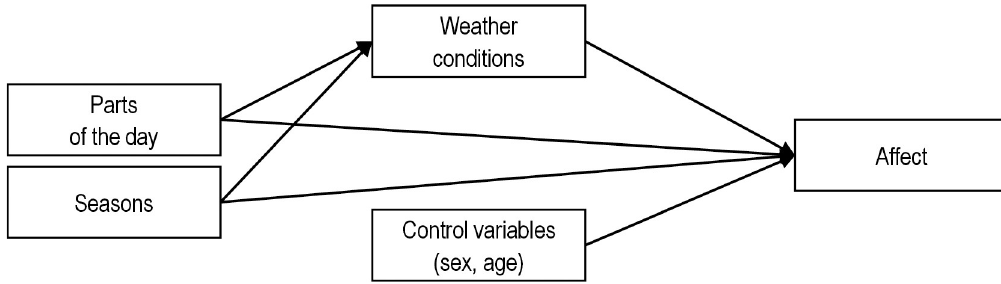
Fig 1. Model for role of seasons, time of day, and weather conditions in affective valence. For presentation simplicity, we grouped weather conditions and control variables in this figure. We examined paths for each variable separately.